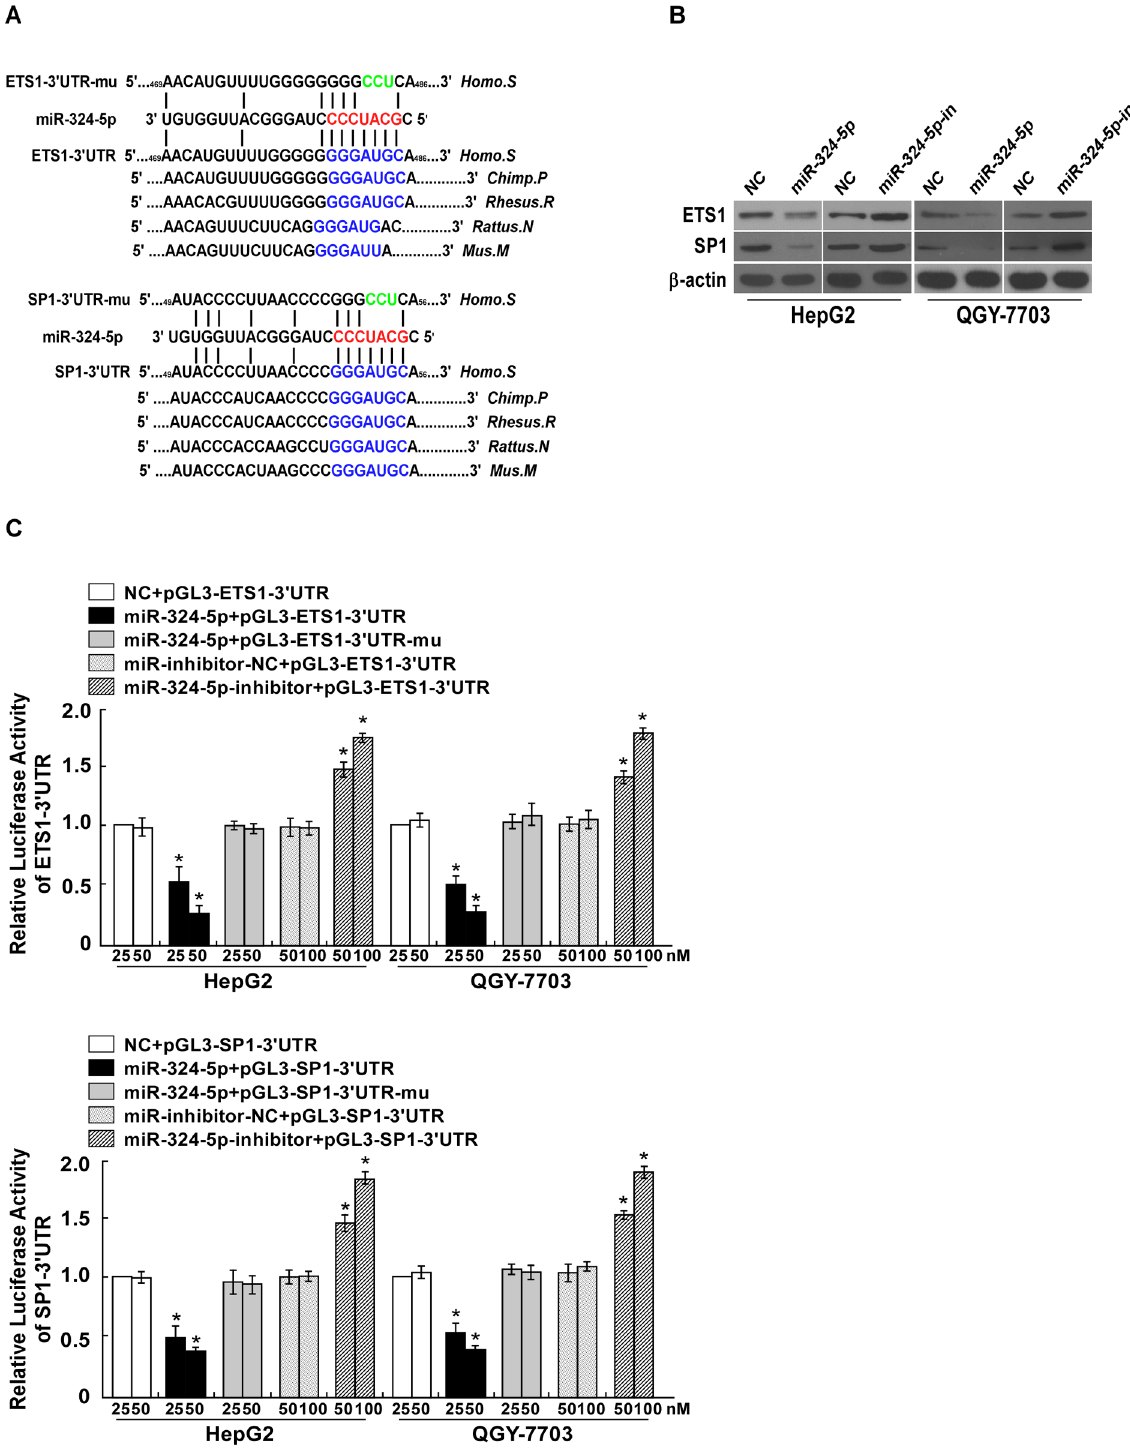
Fig 4. ETS1 and SP1 are the direct targets of miR-324-5p. A. Schematic representation of the mature miR-324-5p sequence, miR-324-5p target site in the 3'-UTR of ETS1 and SP1 mRNA and a 3'-UTR mutant of ETS1 and SP1 mRNA containing three altered nucleotides in the putative target site (shown as ETS1 or SP1 -3'UTR-mu). B. The expression levels of ETS1 and SP1 protein in HCC cells overexpressing miR-324-5p or transfected with miR-324-5p inhibitor, compared with control cells, by western blotting 48 hours after transfection; α -Tubulin served as the loading control. C. Luciferase assay of pGL3- ETS1 - 3'UTR or pGL3- ETS1 -3'UTR-mut reporter, pGL3- SP1 -3'UTR or pGL3- SP1 -3'UTR-mut reporter cotransfected with different amounts (25, 50nM) of miR-324-